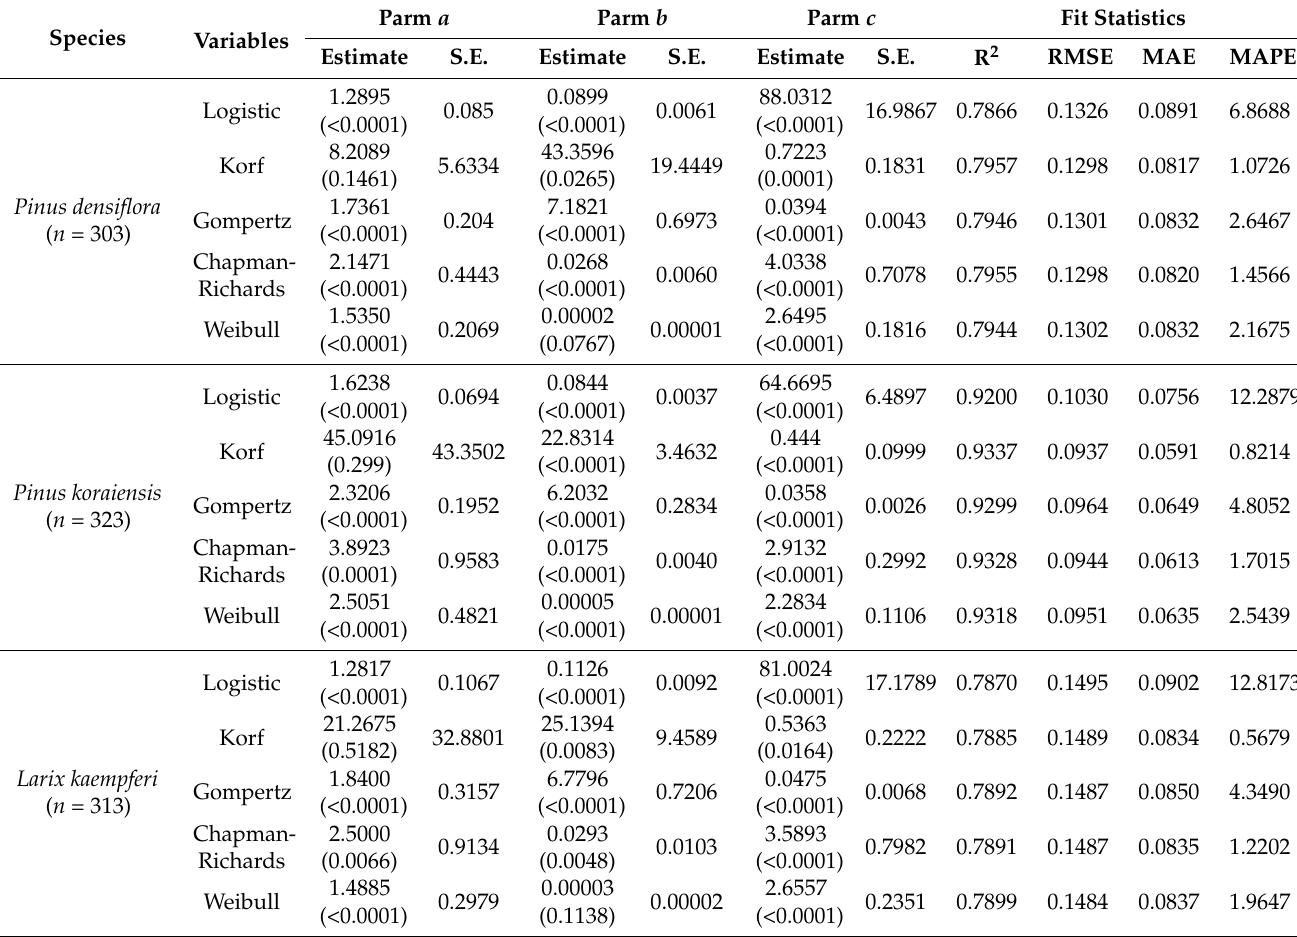
Table 6. Model parameters of stem volume growth functions and indicators of fit.